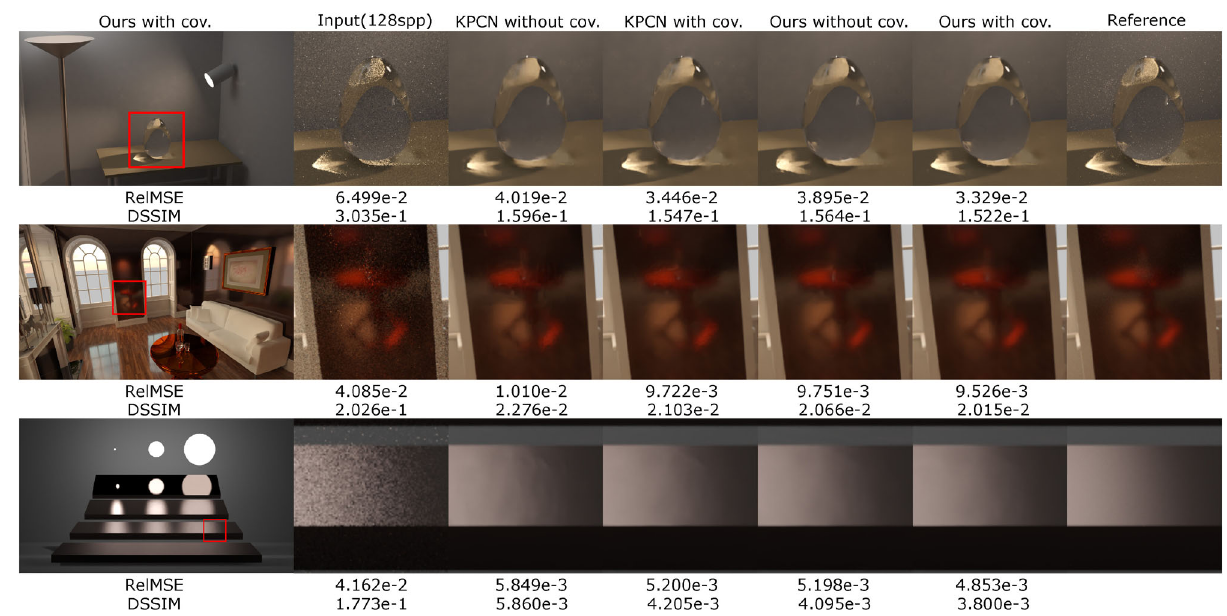
Fig. 9 Comparison of training with and without light transport covariance. We use the feature buffer with and without light transport covariance to train KPCN and our method. Specially selected scenes show the advantages of training with the light transport covariance (cov. means light transport covariance).